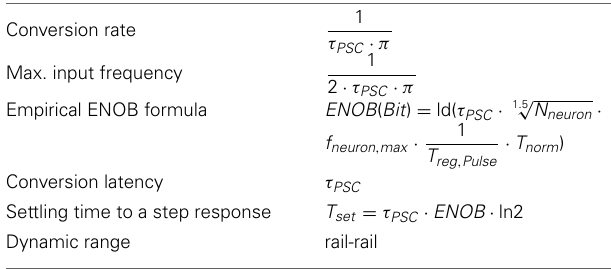
Table 3 | Characteristics of NEF used as a linear